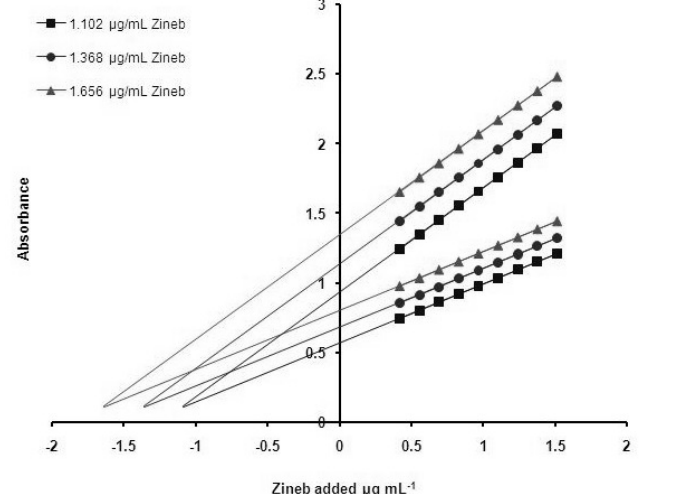
Figure 2. H-point standard addition plots for fixed maneb concentration (0.795 µg mL -1 ) and different concentrations of